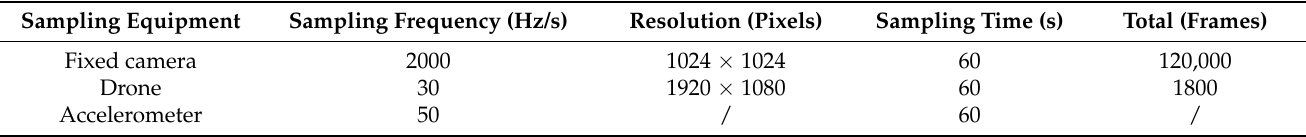
Table 2. Experimental setups of acquisition